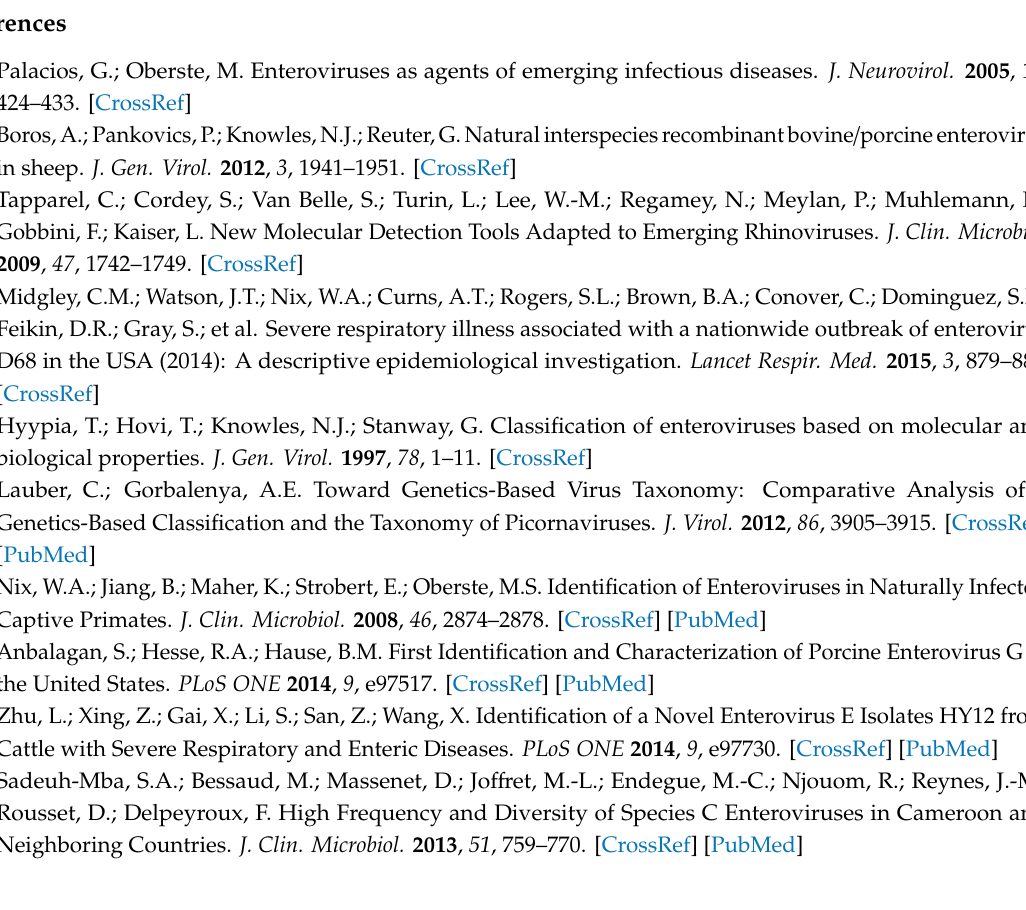
Figure S4: Schematic sequence display of recombinant regions between Ibou002 and Mbo044 genomes with the non-poliovirus strain EV-C99 (KP793035) also isolated in the Congo using the Recombination Detection Program (RDP). The event located in 2A and 2B regions (3740–3980 bps) ( p -value = 0.0307). Table S1: Distribution of great ape individuals by collection sites. Table S2: Number and prevalence of humans and gorillas infected with